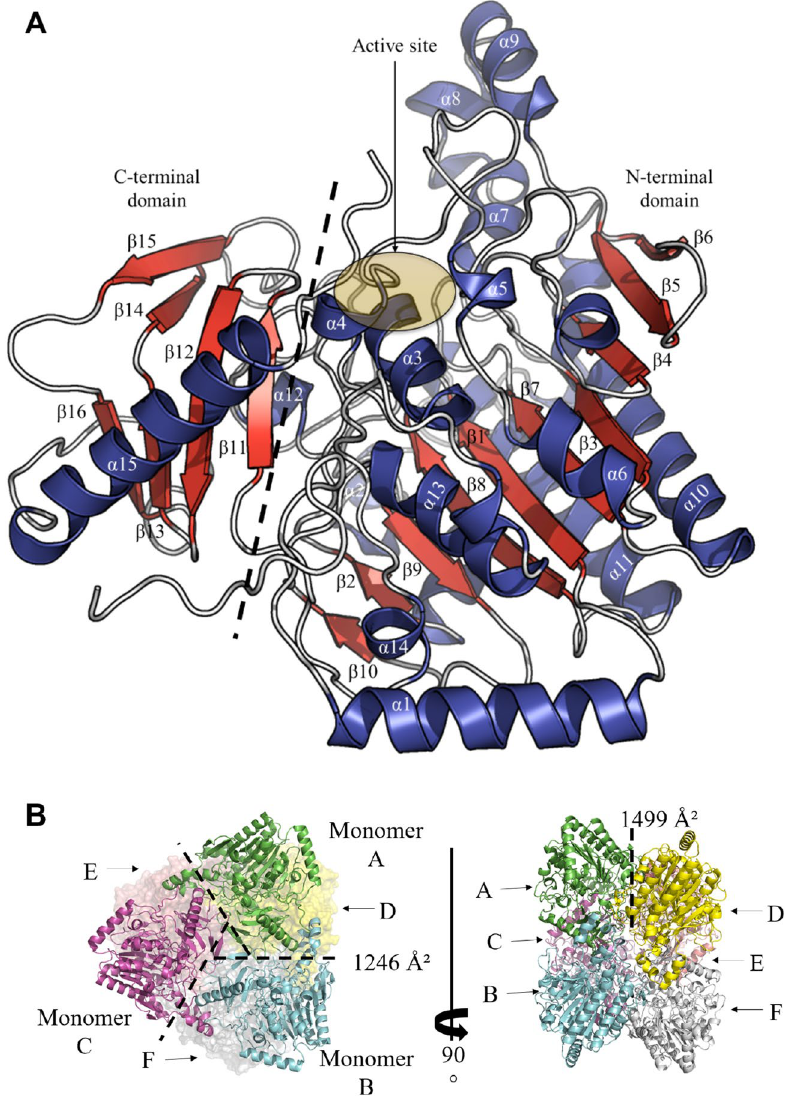
Figure 1. PsFucS1 fold and oligomeric state. ( A ) Cartoon representation of the PsFucS1 structure showing the domain organization and secondary structure elements. The N-terminal domain (Asn21-Leu419: α1-α14 helices and β1–β10 strands) and the C-terminal domain (Val430-Gly521: α15 helix and β11–β16 strands) are separated by a dashed line. The active site position is circled in yellow. Secondary structure elements are colored in red and blue for β-strands and α-helices, respectively. ( B ) Cartoon representation of the PsFucS1 hexamer (trimer of dimers) in the asymmetric unit. Monomers A, B, C, D, E and F are colored in green, cyan, purple, yellow, pink and white,